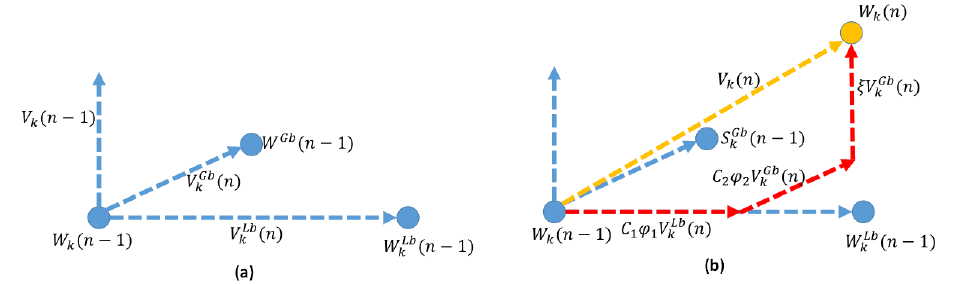
Figure 5. ( a ) Global best, local best, position, and the velocity in the ( n − 1)th iteration. ( b ) Velocity in the n th iteration as a weighted vector addition of previous velocity components and the position in the n th iteration. Table 1. Table of